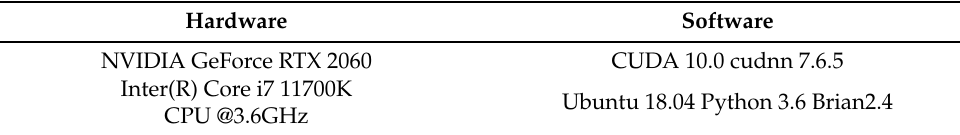
Table 1. Configuration information of the experimental